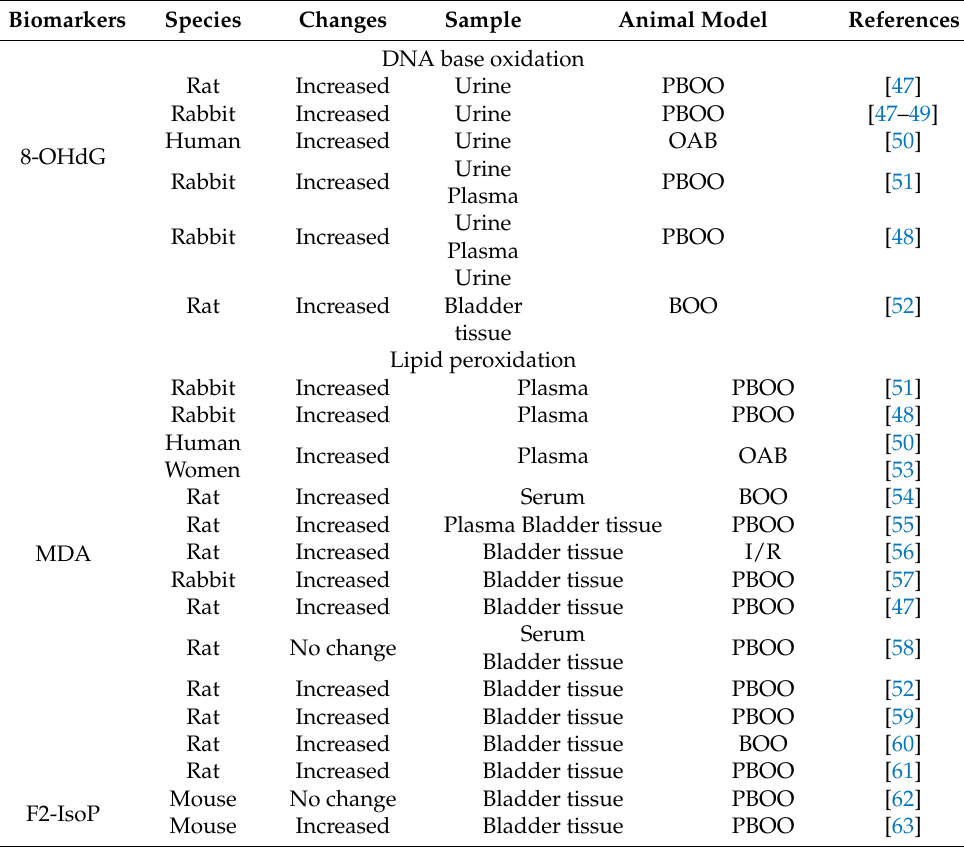
Table 1. Changes in oxidative stress biomarkers in bladder detrusor